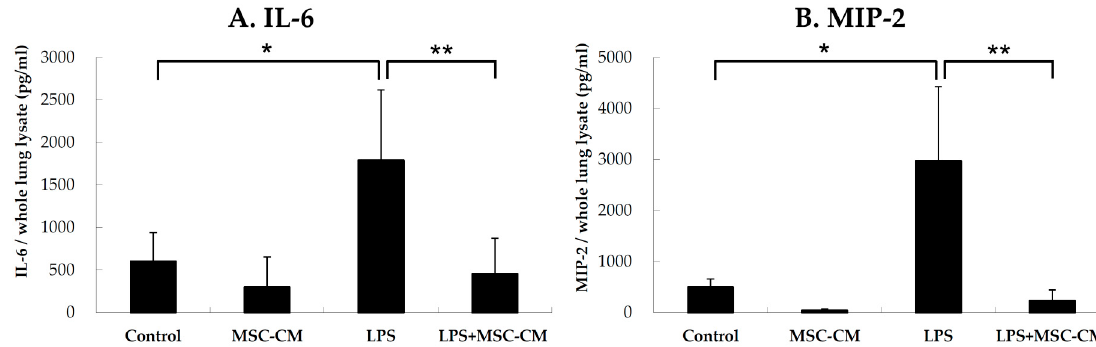
Figure 2. Administration of the MSC-CM decreased the levels of the proinflammatory cytokines, IL-6 and MIP-2, in BALF collected from mice with ALI. In ELISA assays, significantly higher concentrations of ( A ) IL-6 and ( B ) MIP-2 were detected in BALF samples after LPS exposure (LPS) compared to the control group. In contrast, administration of the MSC-CM after LPS (LPS + MSC-CM) resulted in a significant reduction in IL-6 and MIP-2 levels compared to the LPS group. Data are presented as the mean ± SD. * p < 0.05, compared to the controls; ** p < 0.05, compared to the LPS group; n = 6 per group.